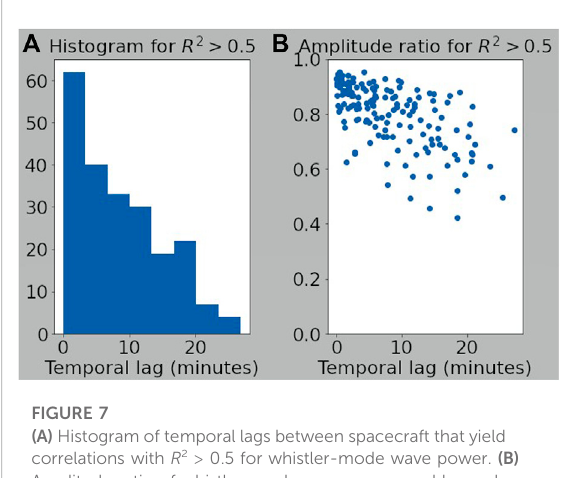
FIGURE 7 (A) Histogram of temporal lags between spacecraft that yield correlations with R 2 > 0.5 for whistler-mode wave power. (B) Amplitude ratio of whistler-mode waves measured by each spacecraft for temporal lags shown in histogram. Subset of correlation data where Van Allen Probes A and B both have L * < 4 taken from Zhang et al.